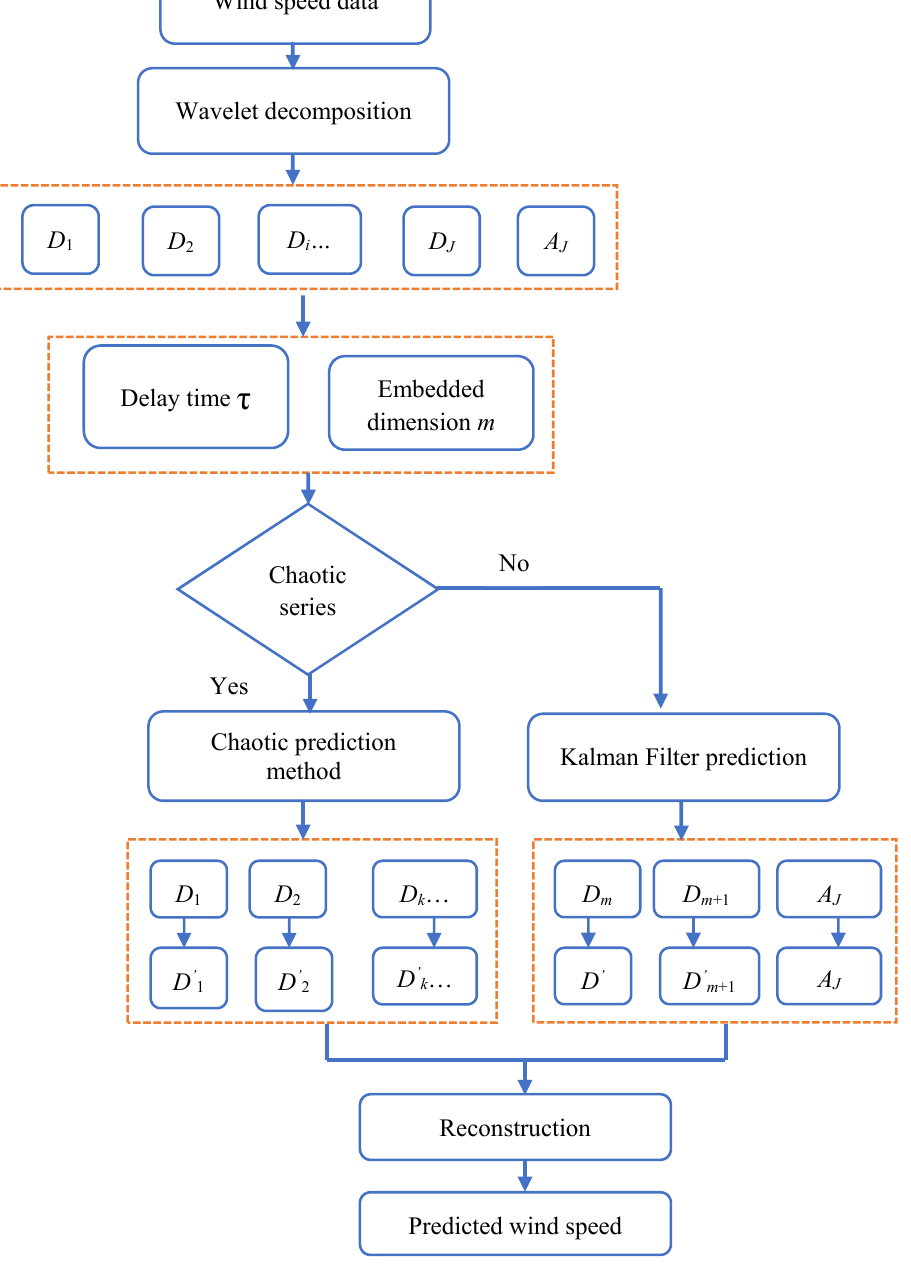
Figure 13. Flow chart of the prediction.